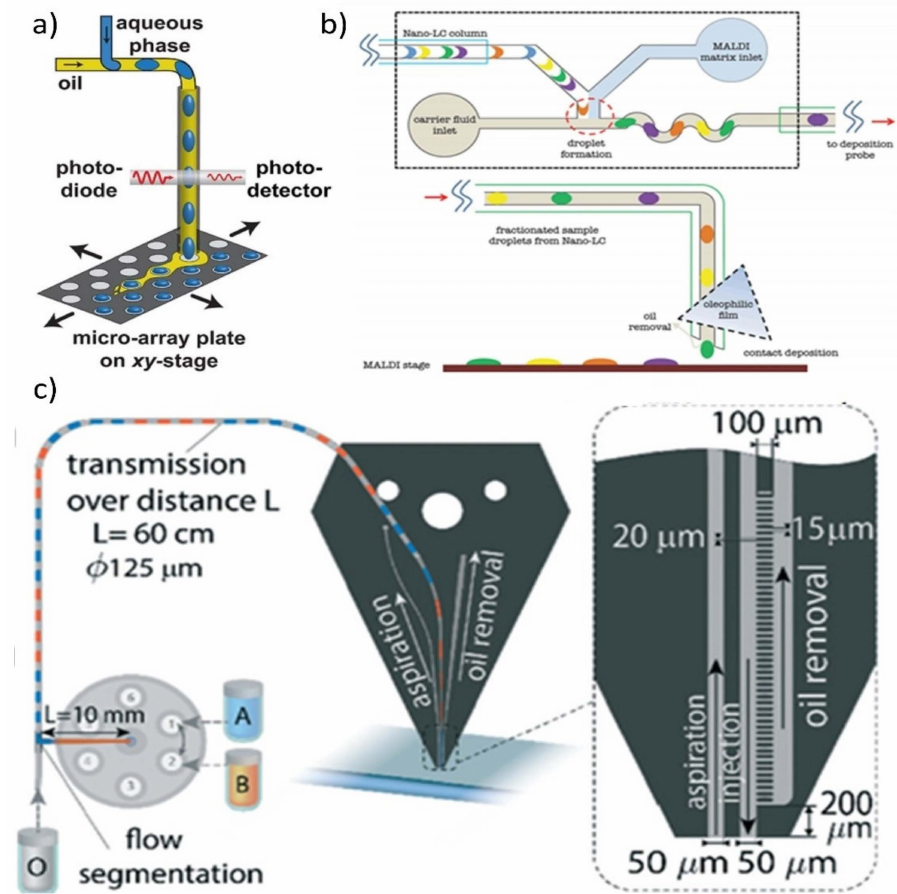
Figure 5. O ff -chip water-based droplet extraction methods. ( a ) Schematic of droplet creation and spotting on a MALDI plate, where the hydrophobic carrier (oil) will evaporate quickly (Reprinted with permission from Reference [103]. Copyright 2013 American Chemical Society); ( b ) schematic of the device that used oleophilic oil film to extract the oil continuous phase and left the aqueous phase to the MALDI plate (Reprinted with permission from Reference [106]. Copyright 2013 PLOS ONE); ( c ) the developed microfluidic probe (MFP) system (Reprinted with permission from Reference [7].